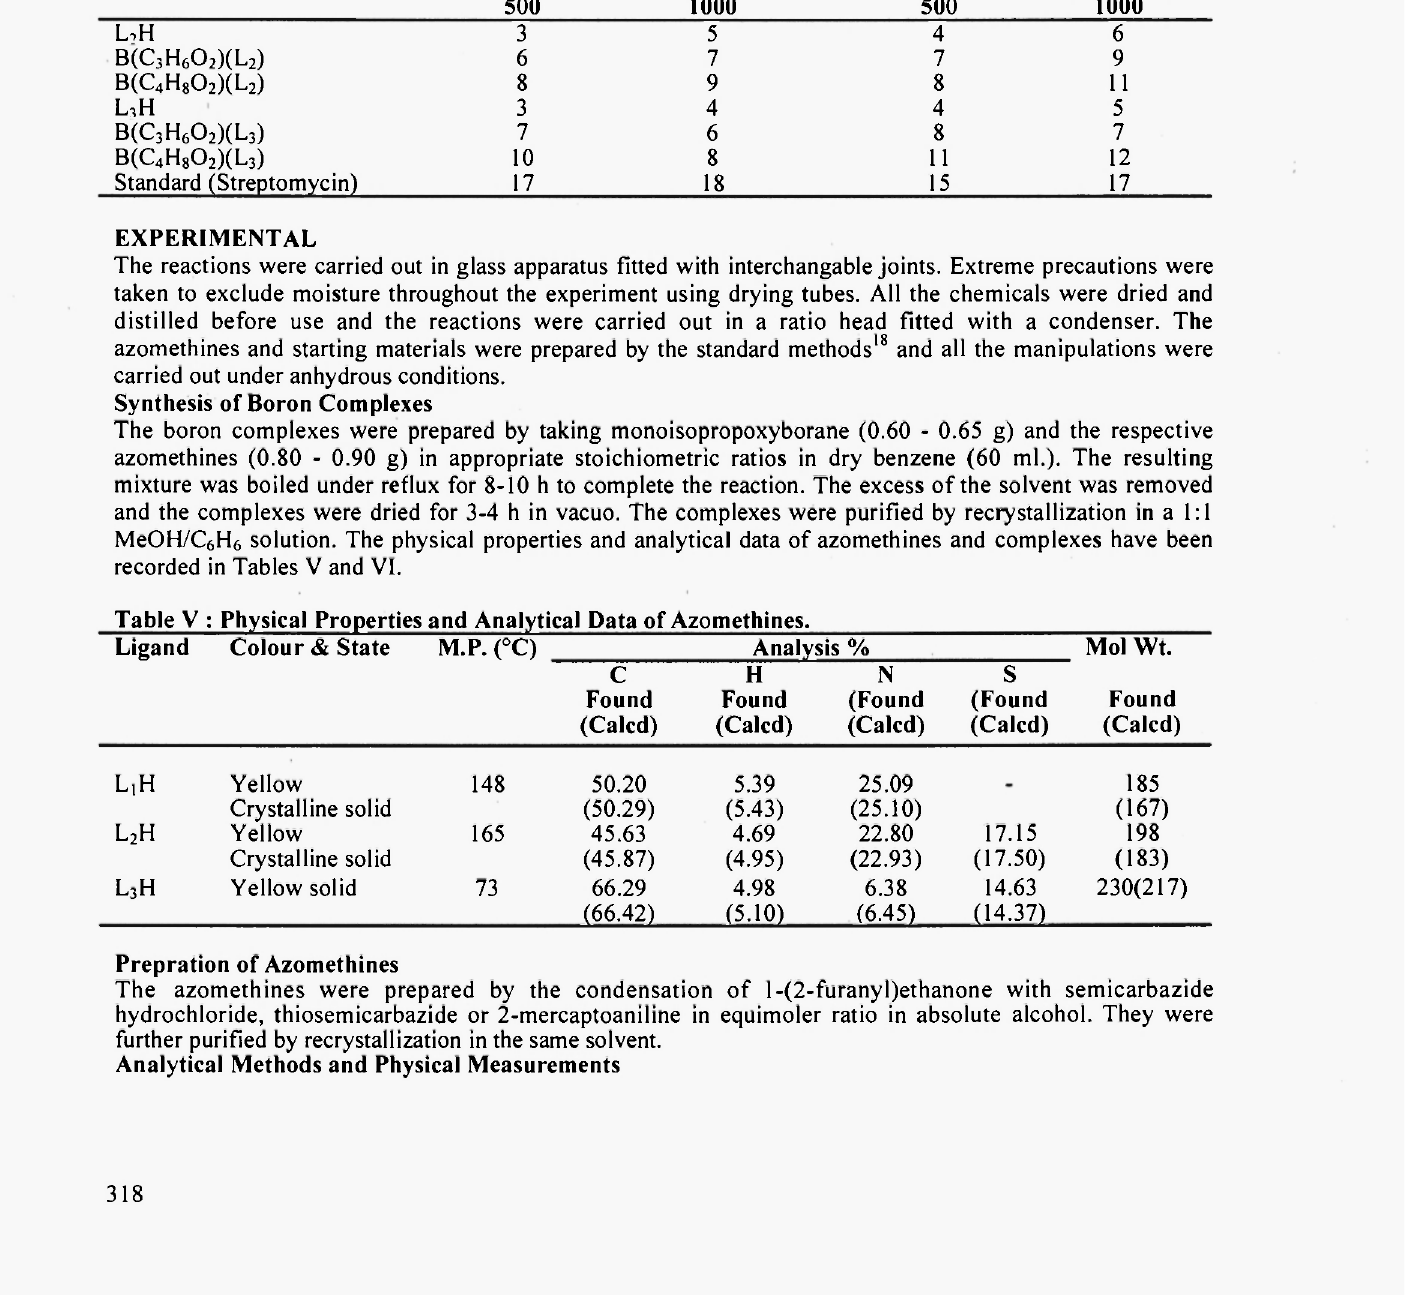
Table IV: Bactericidal Screening Data of Azomethines and their Corresponding Complexes. (Diameter of inhibition zone (mm) after 24 hrs. at 30+2°C) Compound Escherichia coli (-) 500 L-.H